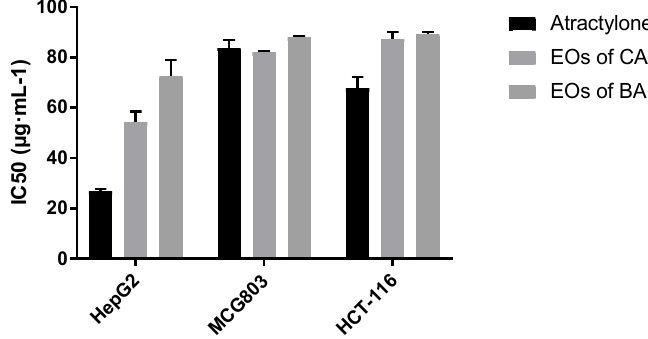
Figure 3. Inhibition of proliferation of HepG2, MCG803, and HCT-116 cells by atractylone, the EOs of CA and the EOs of BA ( n = 3).